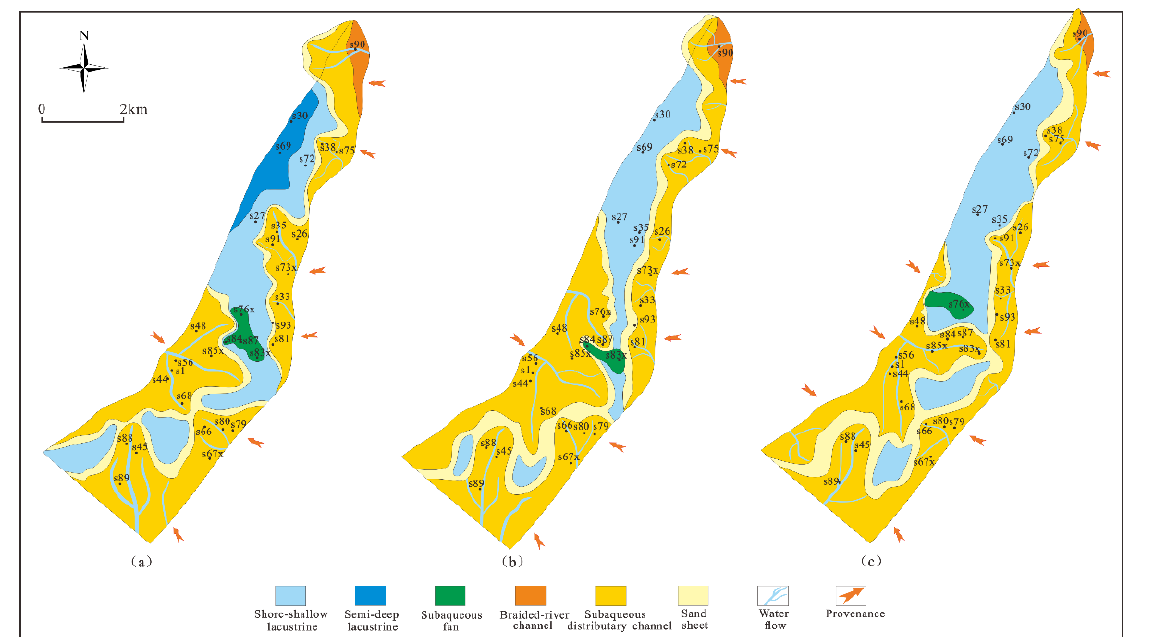
Figure 10. Planar distribution of sedimentary facies in Saidong sub-sag. ( a ) The III sand formation period of K 1 bt 2 , ( b ) the II sand formation period of K 1 bt 2 , and ( c ) the I sand formation period of K 1 bt 2.